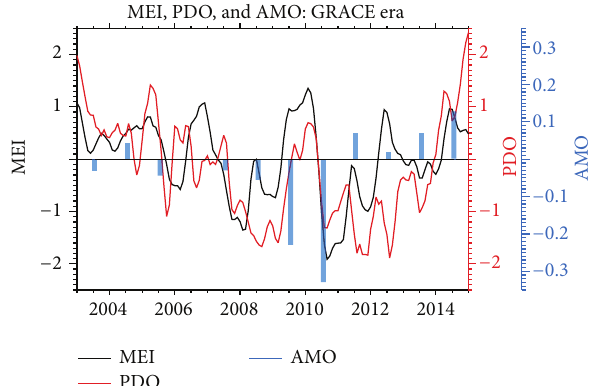
Figure 3: Evolution of ENSO (based on the MEI), the PDO, and AMO during the GRACE